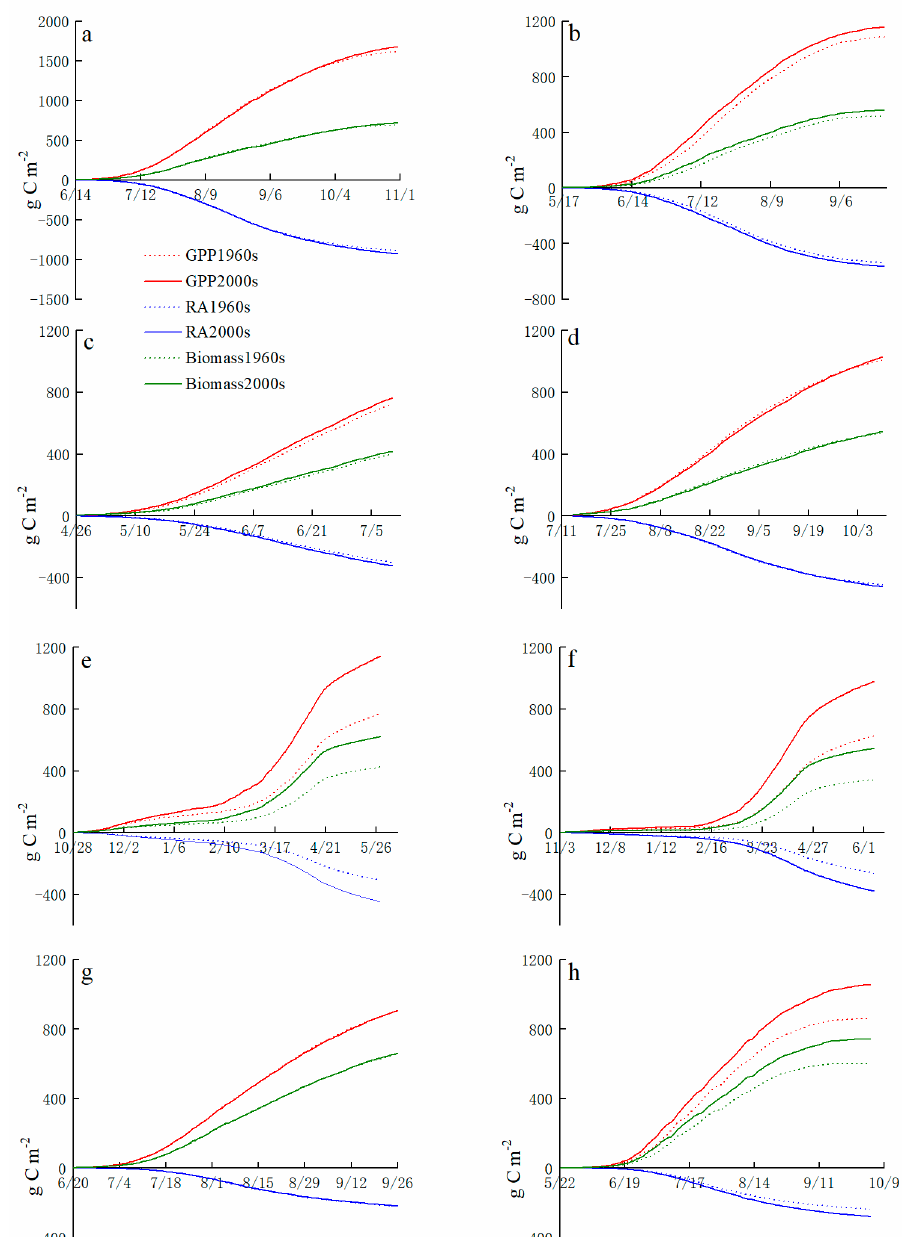
Figure 3. Simulated crop gross primary productivity (GPP), respiration (RA) and above ground biomass (AGB) (g C m − 2 ) for the 1960s and 2000s: ( a ) rice, Changshu, Jiangsu province; ( b ) single rice, Sanjiang, Heilongjiang province; ( c ) early rice, Taoyuan, Hunan province; ( d ) late rice, Taoyuan, Hunan province; ( e ) winter wheat, Changshu, Jiangsu province; ( f ) winter wheat, Fengqiu, Henan province; ( g ) summer maize, Fengqiu, Henan province; ( h ) spring maize, Hailun, Heilongjiang province. Red, blue and green lines, respectively, represent simulated GPP, RA and AGB values for the two periods, and dashed lines pertain to the 1960s, while solid lines pertain to the 2000s.